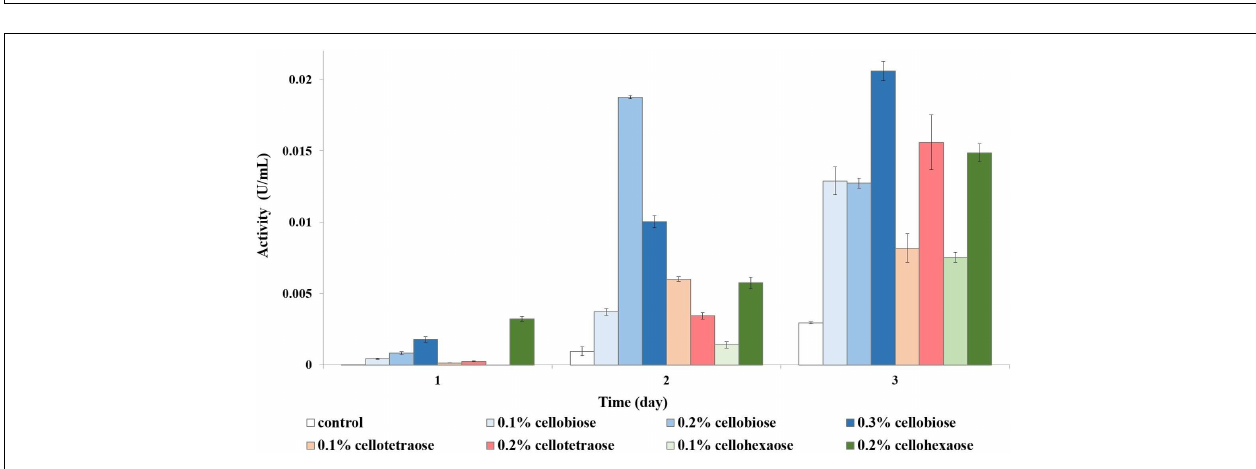
FIGURE 9 | Exoglucanase activity of glycerol-grown biomass in the presence of different inducers and using pNPC as substrate.